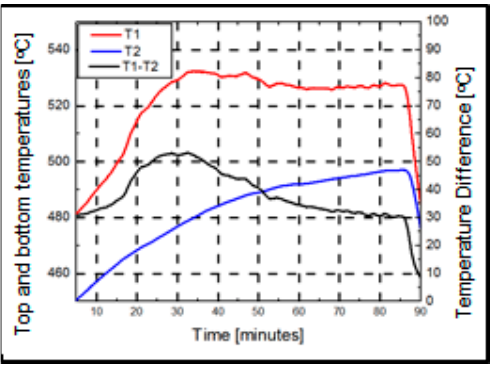
Figure 15. Temperatures recorded on top of the (T1) and below the surface (T2) during the steady heating of the piston model with AISI304-(Al + 50%ZrO 2 ) 12-layer TBC coating. The results for the piston with AISI304-(Al + 50%ZrO 2 ) 12 layer TBC and without TBC are shown in the Figure 16.